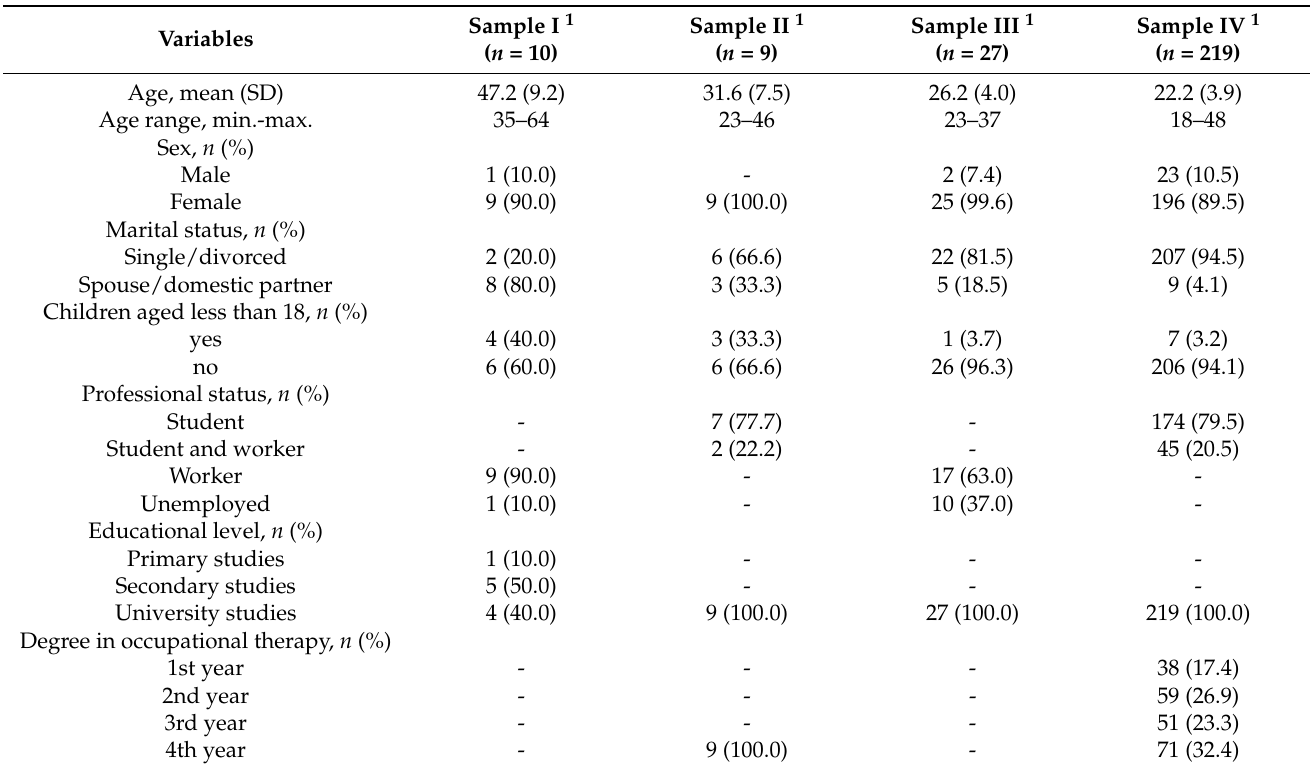
Table 1. Sociodemographic features of the study